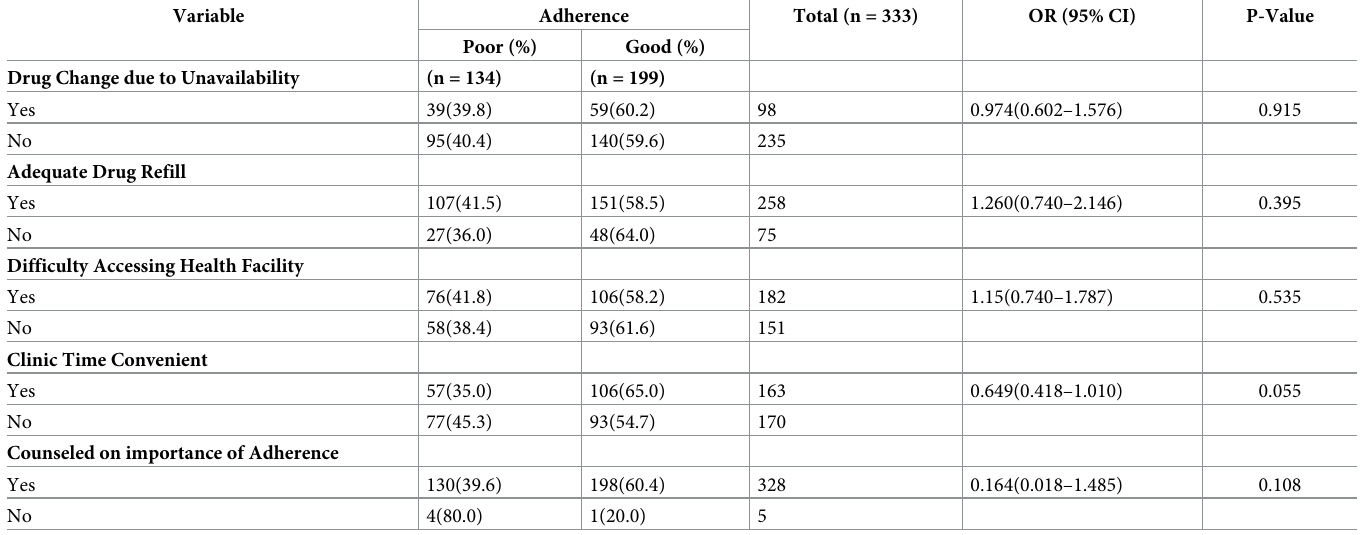
Table 5. Health system-related characteristics associated with ART